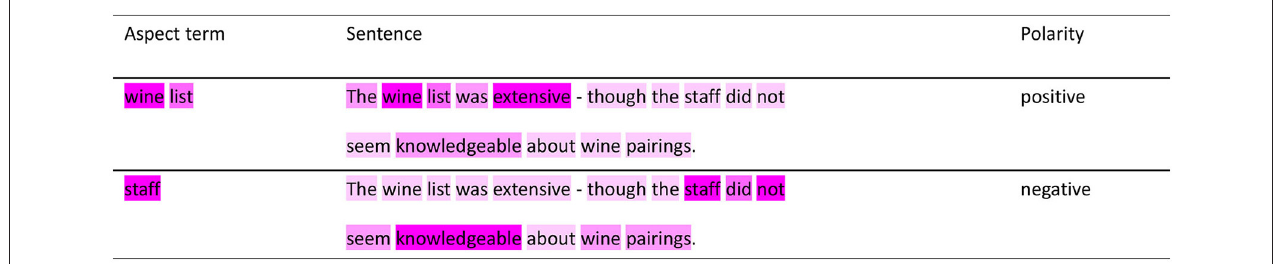
FIGURE 3 | Visualize the weight of attention for aspect terms and sentences by